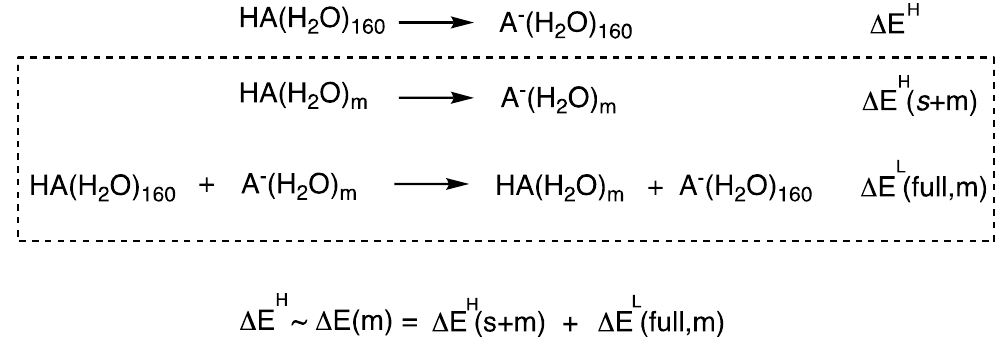
Figure 3. Illustration of the ONIOM-ME approach for calculating deprotonation energies.